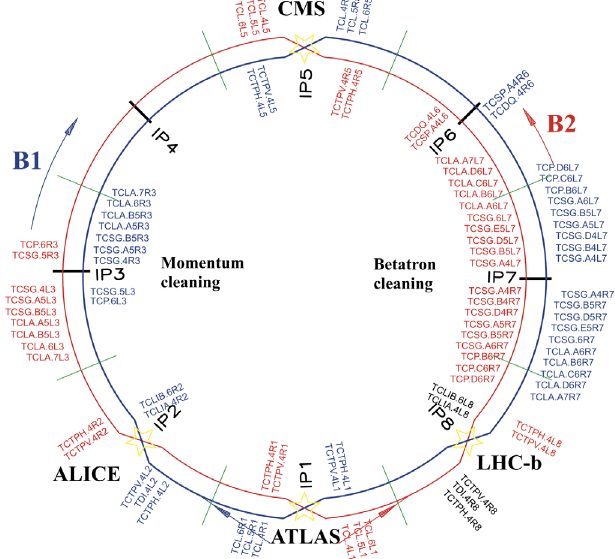
FIG. 1. Schematics of the LHC Run II collimation layout (prior to 2019)